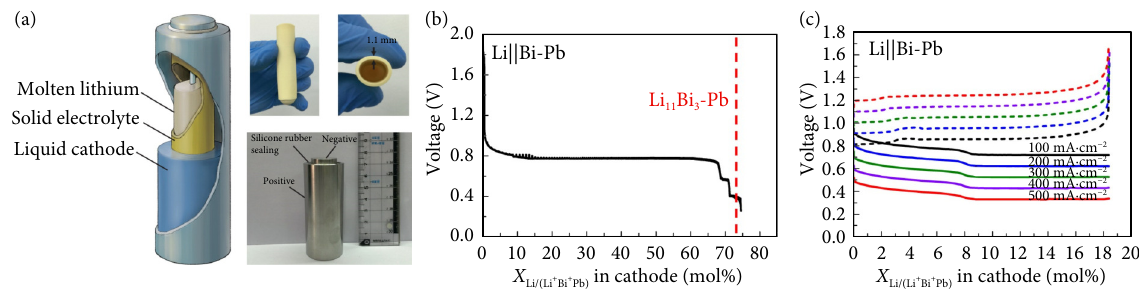
Fig. 10 (a) Schematic of the Li|LLZTO|Bi–Pb battery. (b,c) Electrochemical performance of Li|LLZTO|Bi–Pb. Reprinted with permission from ref. [108], ©